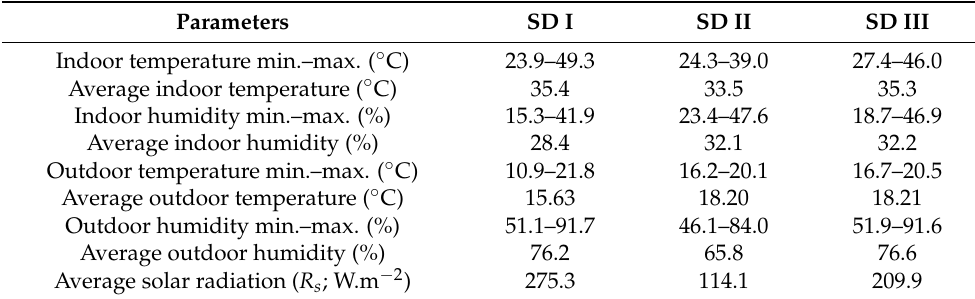
Table 1. Values for indoor and outdoor